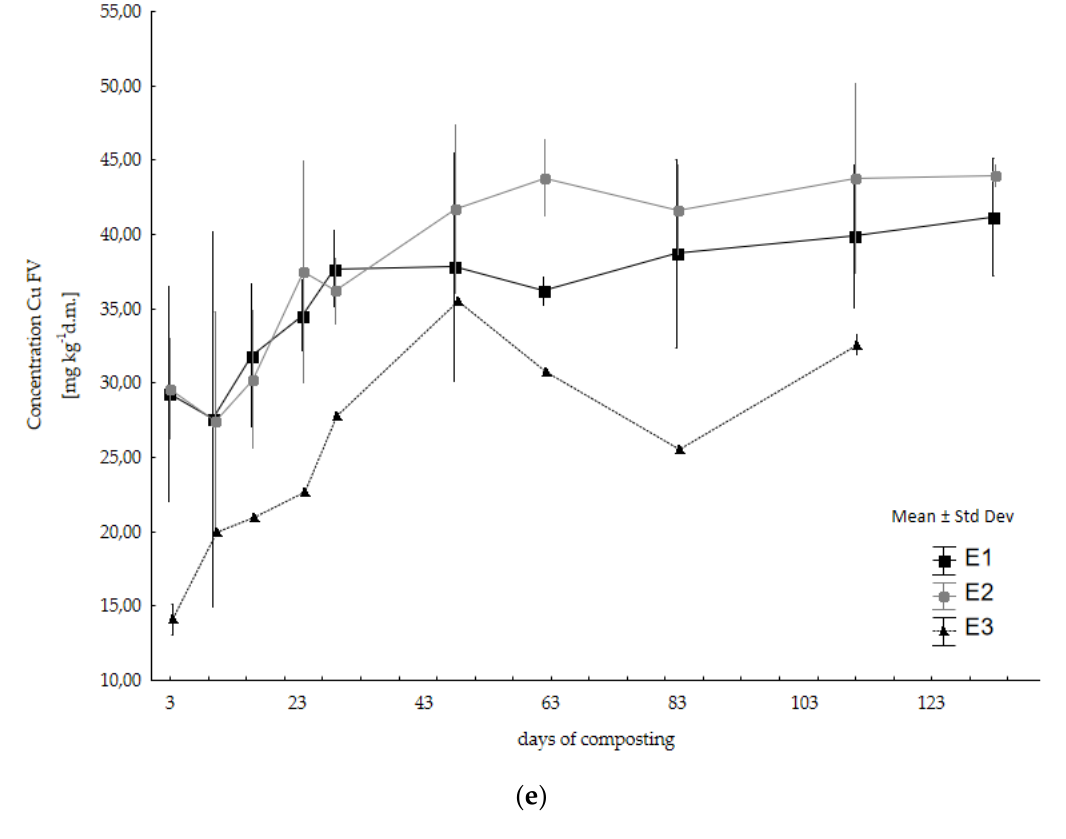
Figure 2. Concentration of Cu in particular fractions FI ( a ), FII ( b ), FIII ( c ), FIV ( d ), and FV ( e ) in stages E1, E2, E3. Table 5. Increments of Cu and Zn fractions during composting (end vs. start. %) for composts with different initial C/N and inactivation rate (IR)